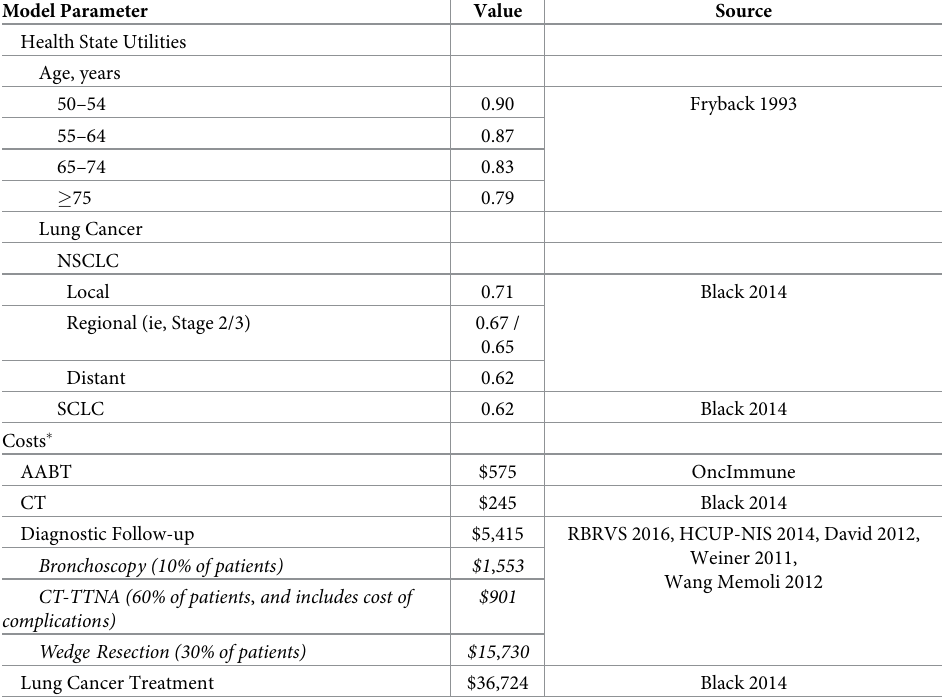
Table 2. Health state utilities and costs for patients who have incidentally detected pulmonary nodules, are at intermediate risk, and were scheduled for CT surveillance